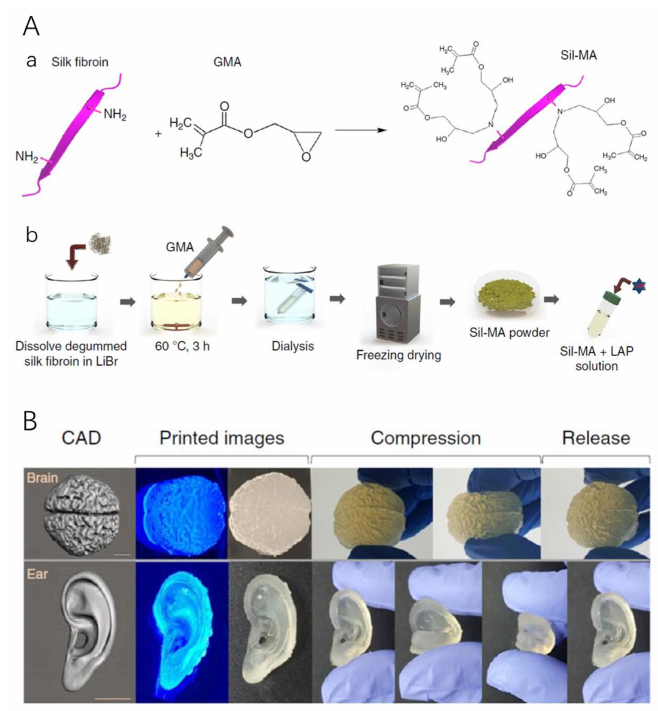
Figure 6. ( A ) Regenerated silk fibroin (RSF) was chemically modified with glycidyl methacrylate (GMA) to form (Sil-MA) as a pre-hydrogel. ( a ) RSF covalently immobilized with GMA, generating a vinyl double bond as a UV-crosslinking site. ( b ) Schematic diagram of the methacrylation process of SF; LAP represents Lithium phenyl(2,4,6-trimethylbenzoyl) phosphinate which is a photoinitiator. ( B ) Representative 3D printed models (brain and ear) via a digital light processing (DLP) printer using Sil-MA as a bioink, showing complex structure reflecting their CAD images. Reprinted with permission from